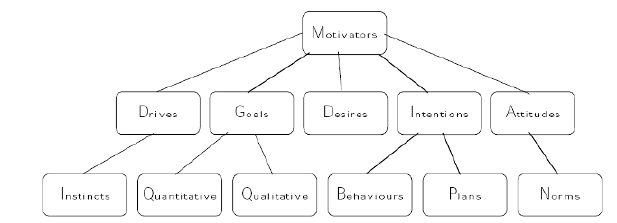
Figure 1. Five major Motivational Control States with (non-exhaustive set of) subtypes.